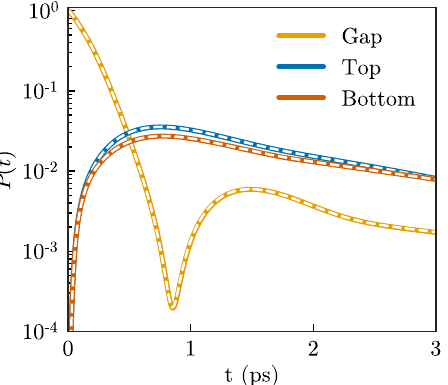
Figure 2: Population of Gap (orange), Top (blue) and Bottom (red) emitters within the hybrid metallodielectric system shown in Figure 1 when Gap is initially ( t = 0) excited, while Top and Bottom are in their ground states. The colored lines correspond to a direct discretization of the photon continua in frequency, while the white dashed lines correspond to the dynamics predicted by the